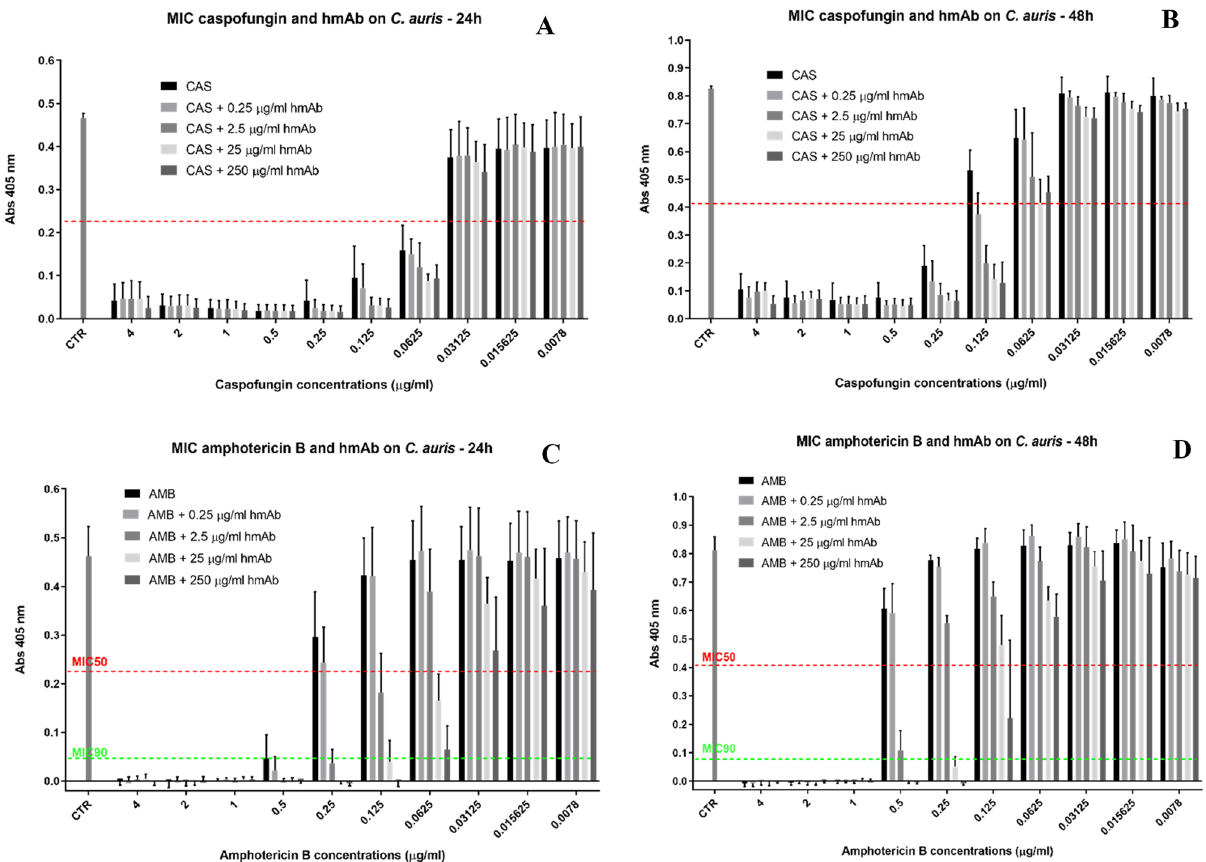
Figure 9. Figure 8A,B, MIC assays of caspofungin alone and in combination with different concentrations of humanized H5K1 at 24 and 48 h. Figure 8C,D, MIC assays of amphotericin B in combination with different concentrations of humanized H5K1 at 24 and 48 h.